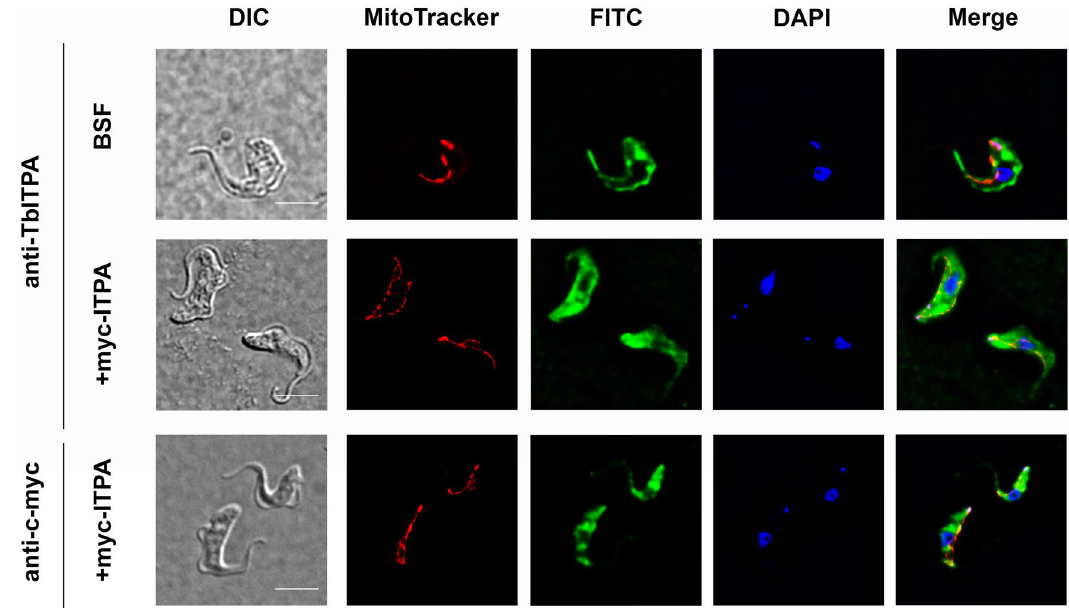
Figure 4. Subcellular localization of ITPA in bloodstream T . brucei cells. Immunofluorescence microscopy analysis was performed to establish the subcellular localization of ITPA in parental bloodstream T. brucei cells (BSF) (upper row) and mycTbITPA-overexpressing cells (+ myc-ITPA) (middle and lower row). Nuclear and kinetoplast DNA were stained with DAPI. The mitochondrion was visualized with MitoTracker Red CMXRos and ITPA was detected with anti-ITPA and Alexa Fluor 488 goat anti-rabbit as secondary antibody (upper and middle row) or anti-myc and Alexa Fluor 488 goat anti-mouse as secondary antibody. Images were collected with an Olympus microscope and Cell R IX81